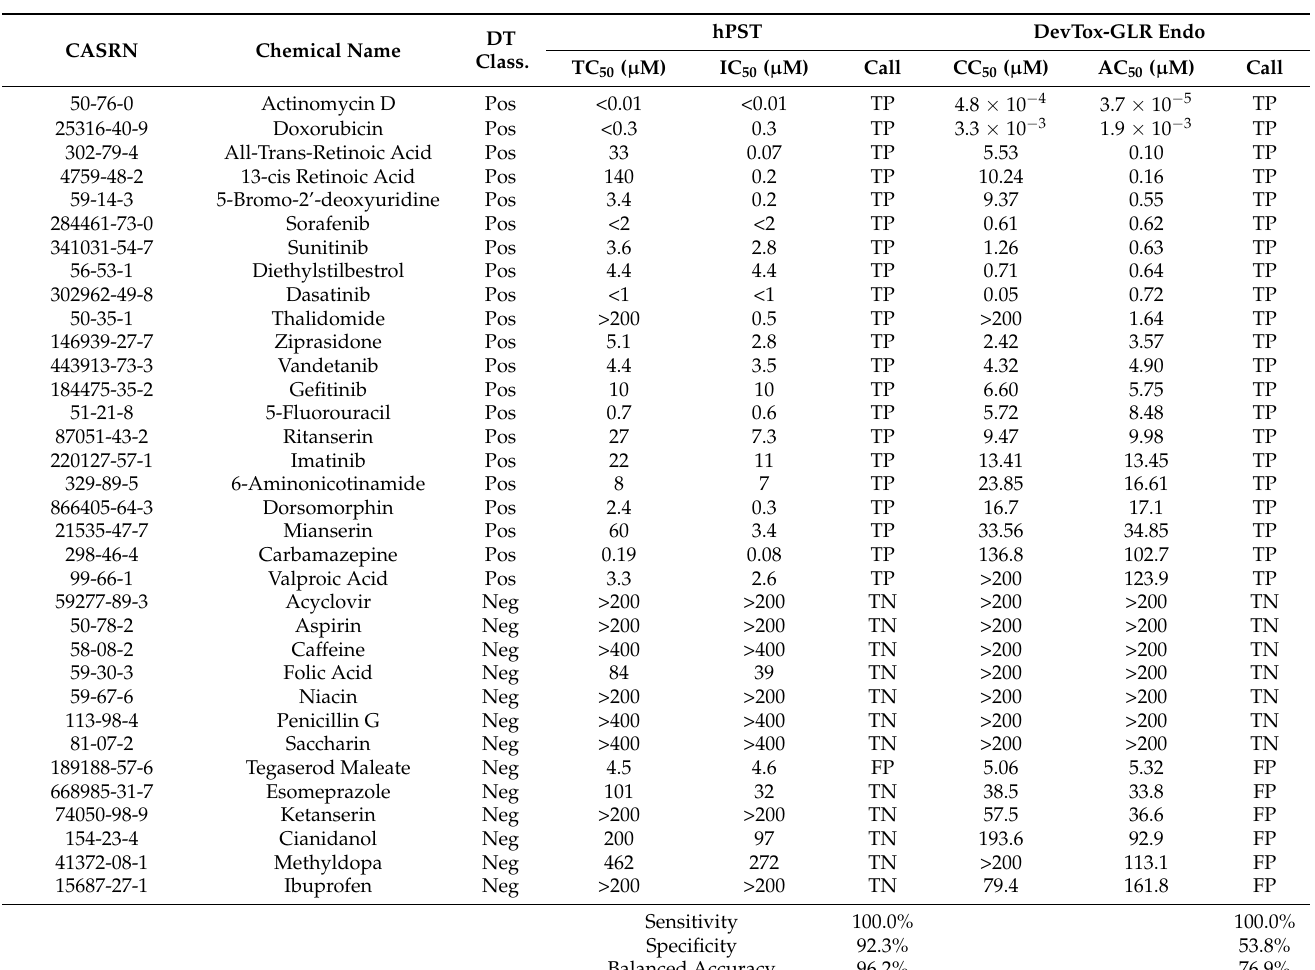
Table 3. Comparison of chemical responses between the DevTox GLR-Endo and hPST assays. Comparisons were drawn based on reported hPST assay